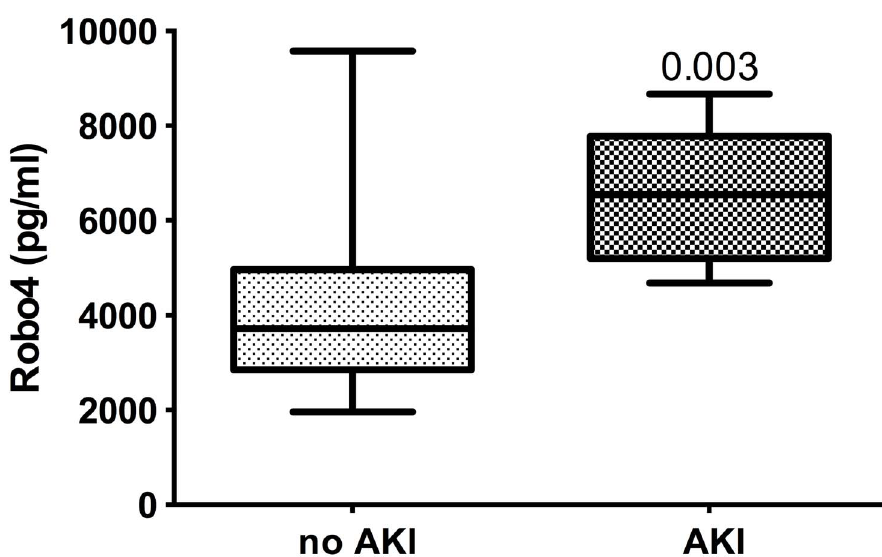
Figure 3. Plasma Robo4 levels in patients with or without AKI according to AKI Network classification. Plasma levels of Robo4 in patients, 2 h post-cardiac surgery requiring cardiopulmonary bypass with or without acute kidney injury (AKI); assigned according to AKI Network clinical classification. Data presented as median, IQR concentrations (pg/ml) of Robo4 (n=26, non-AKI and n=6, AKI).